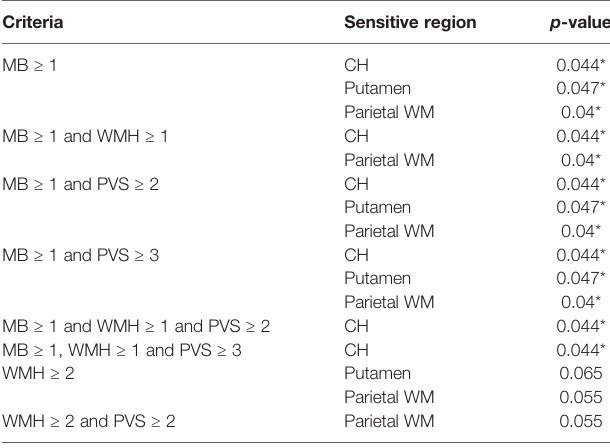
SD, standard deviation; CSVD, cerebral small vessel disease; PVS, perivascular space; WMH, white matter hyperintensity; MB, microbleed; WM, white matter; GM, gray matter; CH, caudate head; T2DM, type 2 diabetes. *P < 0.05.